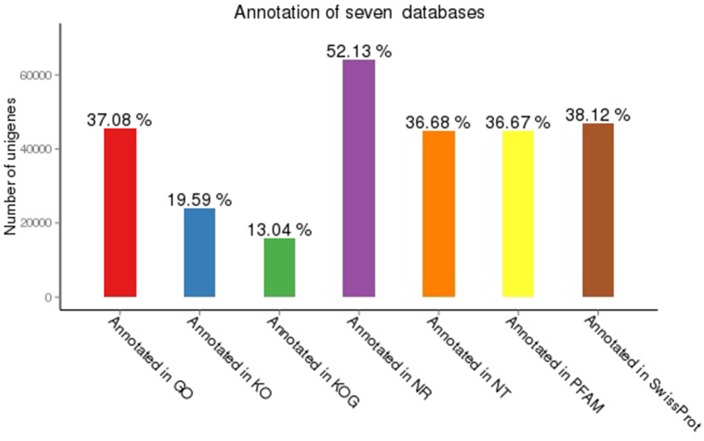
Unigenes matched in seven databases.